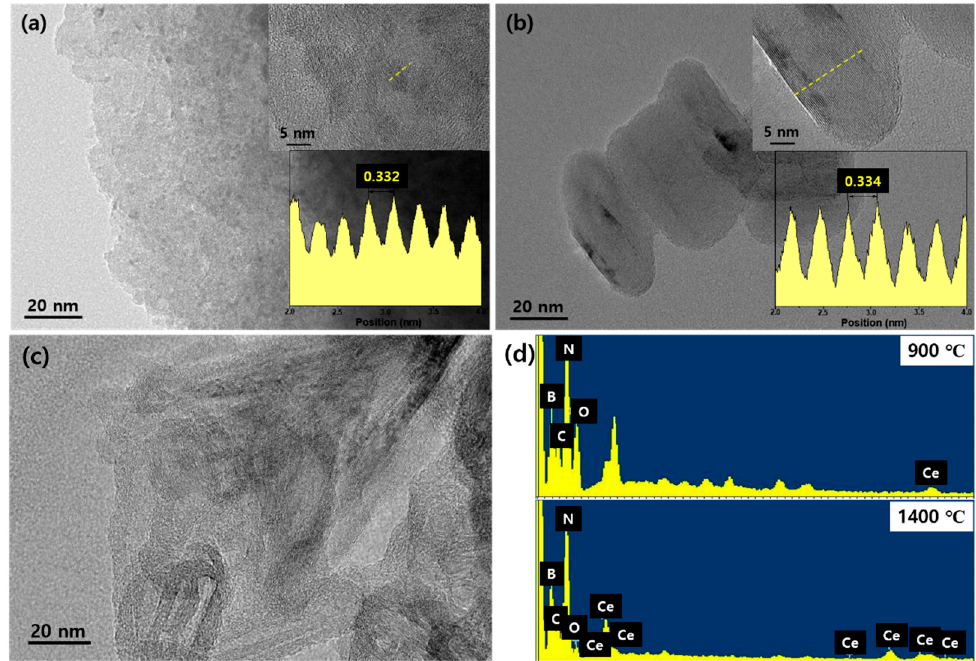
Figure 4. ( a ) Transmission electron microscopy ( TEM) image of pyrolysis at 900 °C of Ce 3+ -dope h-BN nanophosphors (inset up; high-resolution, inset down; line profile), ( b ) TEM image of re-heating at 1400 °C of Ce 3+ -dope h-BN nanophosphors (inset up; high-resolution, inset down; line profile), ( c ) TEM image of observed remain carbon in pyrolysis at 900 °C and ( d ) X-ray spectroscopy (EDX) data of pyrolysis at different tempering temperatures (element identification: B, C, O, N and Ce).